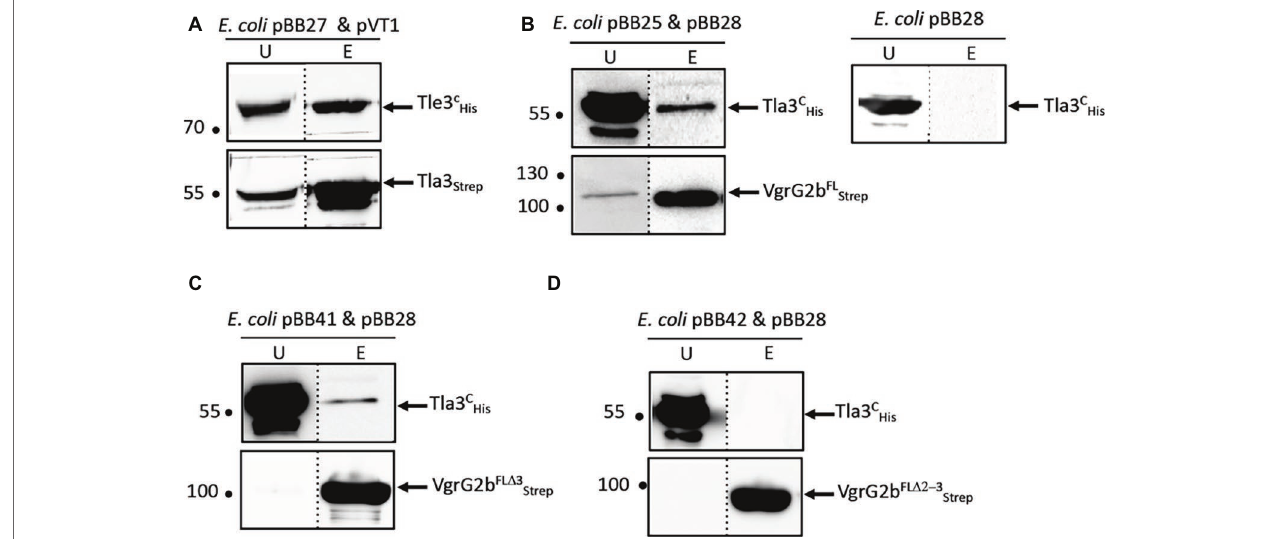
FIGURE 4 | Tla3 interaction with Tle3 (A) and VgrG2b (B–D) . Copurification assay on StrepTactin column of Tla3 c STREP with Tle3 c His produced in E. coli BL21(DE3) pLysS from pBB27 and pVT1, respectively, (A) or of Tla3 c His with VgrG2b FL STREP (B) or VgrG2b FLD3 STREP (C) or VgrG2b FLD2-3 STREP (D) produced from pBB28 and pBB25 (B) or pBB41 (C) or pBB42 (D) . The unbound (U) and eluted (E) fractions were collected and subjected to SDS-PAGE (10.5%) and Western blot analysis using anti-His antibody (upper) and anti-streptavidin antibody (lower). The dashed line separates lanes from non-adjacent part of the same gel. The position of the proteins and the molecular mass markers (in kDa) are